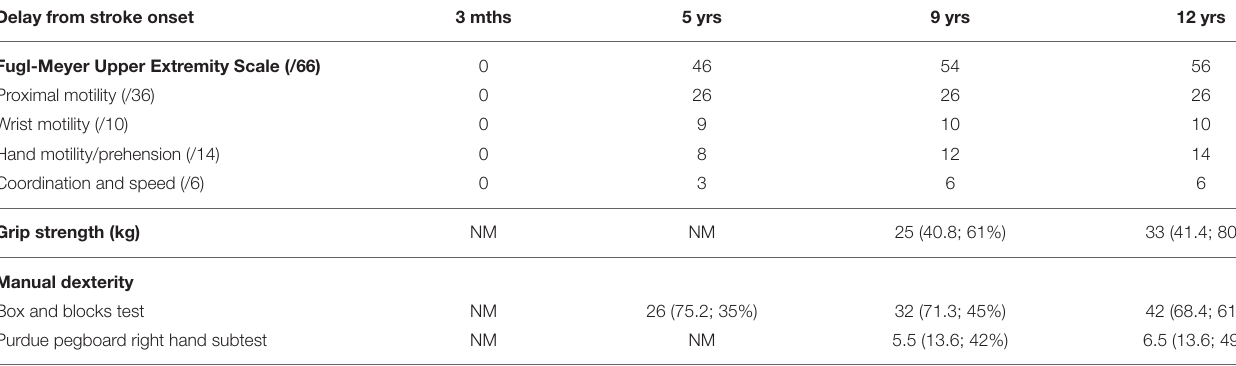
TABLE 1 | Standardized clinical evaluation of the paretic hand of the patient, at 3 months, and 5, 9, and 12 years post-stroke. Delay from stroke onset